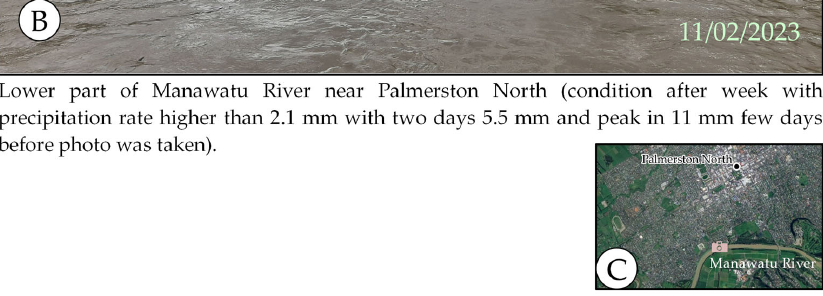
Figure 4. Precipitation influences on the Lower Manawatu River near Palmerston North. ( A ) He Ara Kotahi Lookout during warm weather. ( B ) He Ara Kotahi Lookout after a week of precipitation. ( C ) Overview map of location, where photos have been